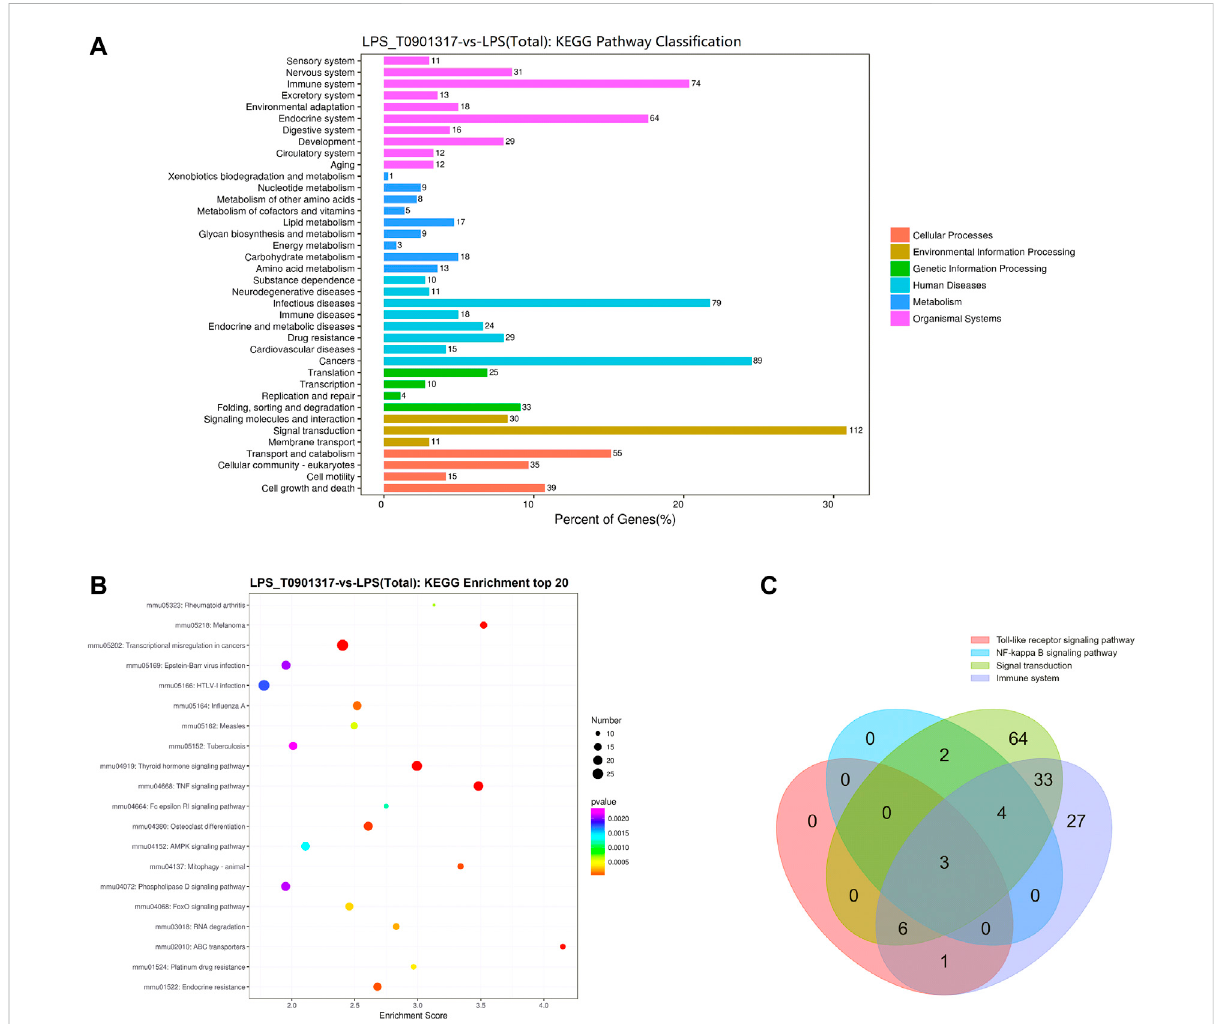
FIGURE 4 RNA-sequencing analysis of T0901317 treating cells. (A,B) Alternative mRNA splicing analysis was performed basing on RNA-seq and KEGG enrichment analysis in LPS/T0901317 vs LPS group were shown here. (C) DEGs in four pathways (signal transduction 112 genes, immune system 74 genes, TLR signaling pathway nine genes and NF- κ B signaling pathway 10 genes) were subjected to overlapped analysis in a Venn diagram. The number of overlapping genes was shown in the overlapping